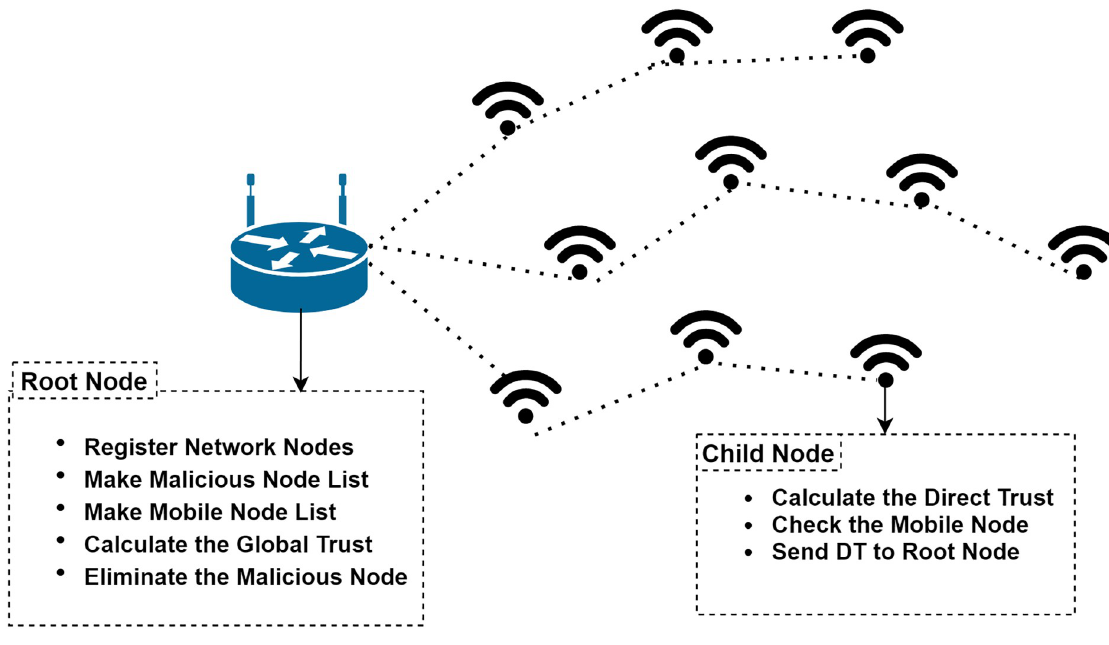
Fig 1. An example of IoTs.